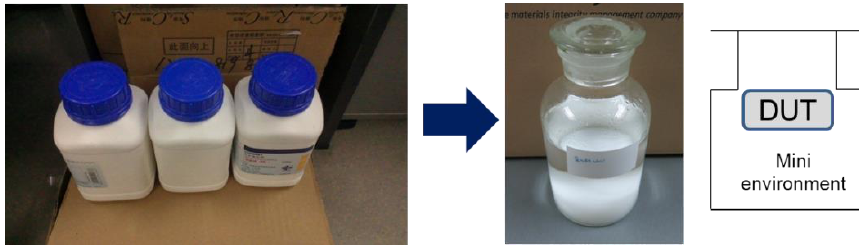
Figure 4. Mini-environment built with a saturated salt solution sealed in glass chamber.